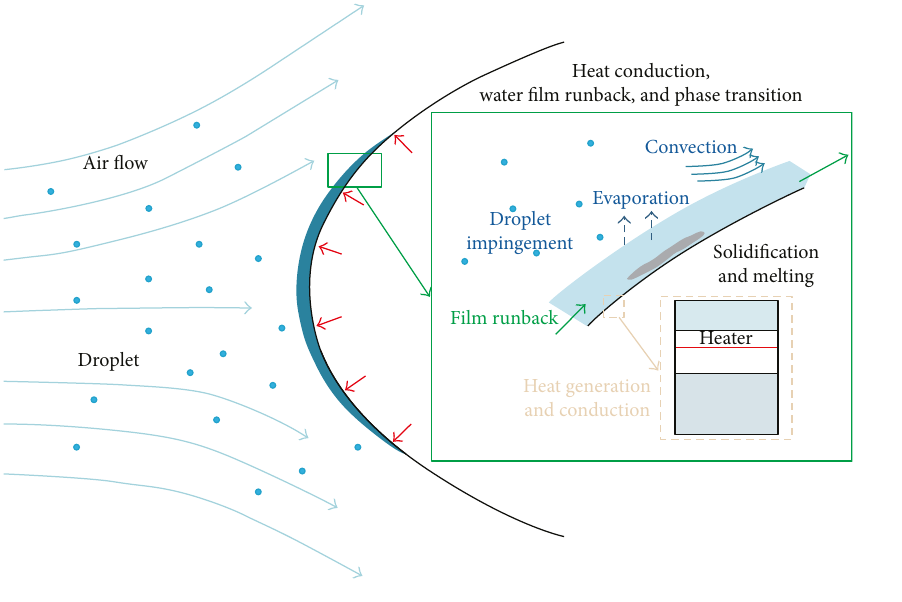
Figure 1: Mass and energy balance of deicing